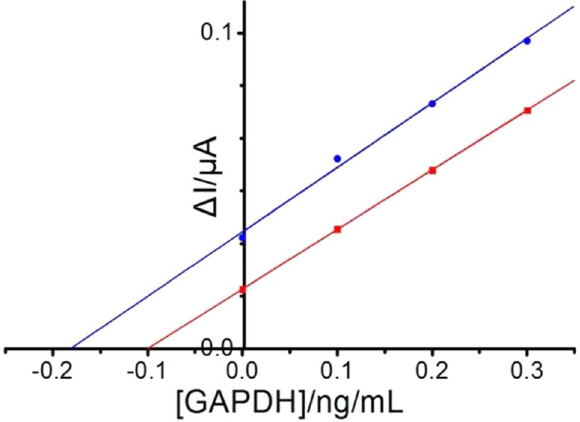
Figure 7. Standard addition plot for GAPDH detection in real human serum